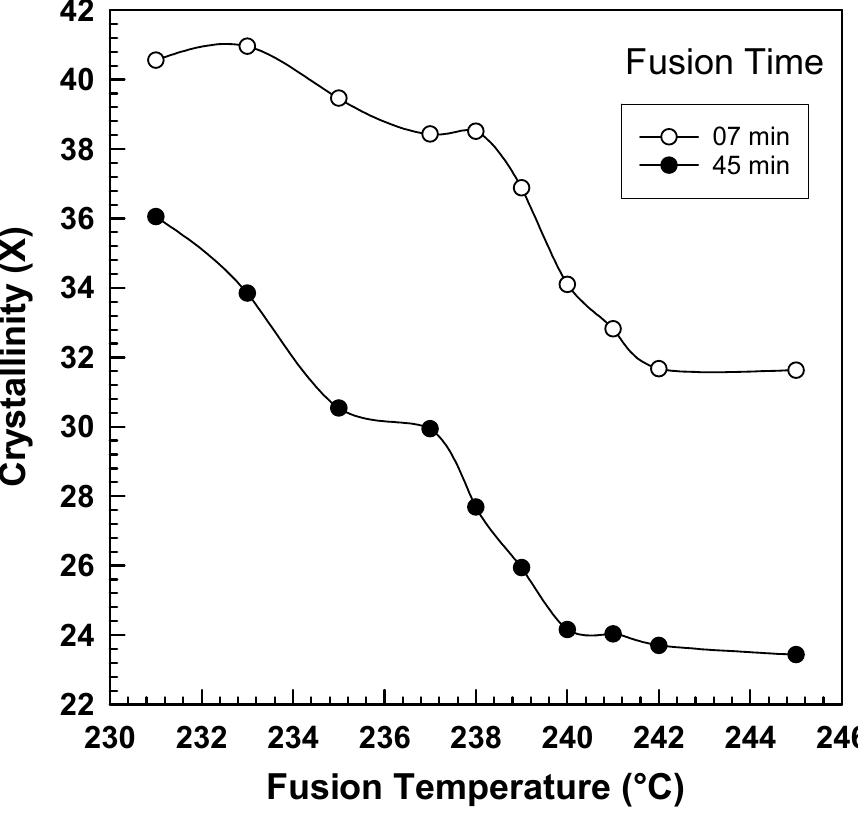
Figure 7. PA6 crystallinity vs. fusion temperature at di ff erent fusion times.